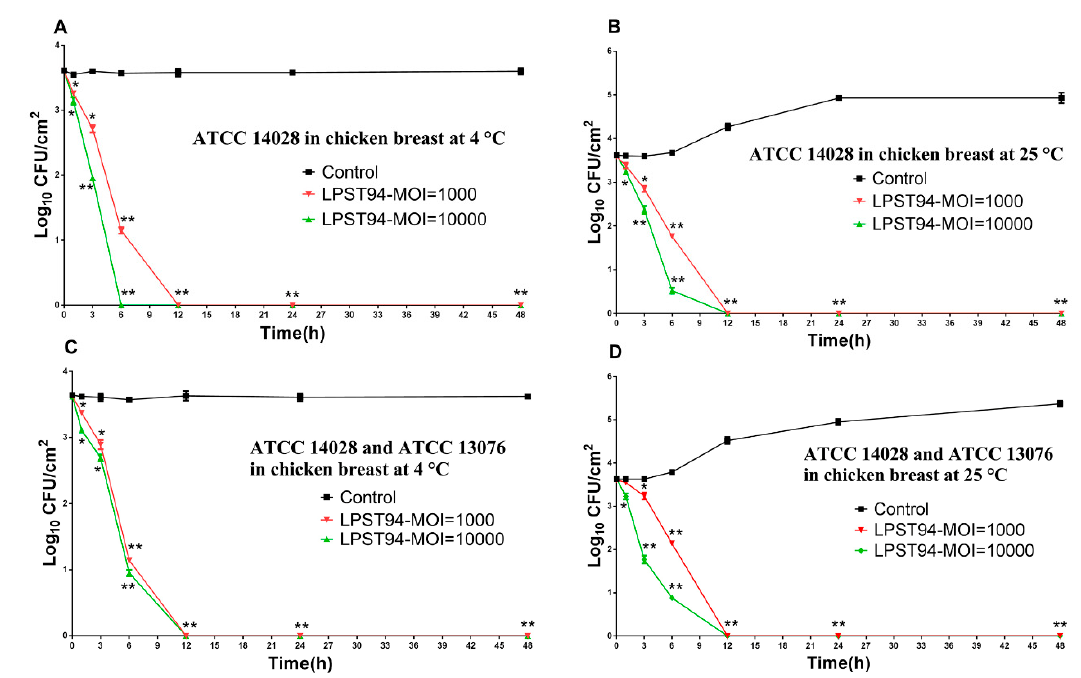
Figure 6. E ff ectiveness of phage LPST94 in reducing the S. Typhimurium ATCC 14028 and S. Enteritidis ATCC 13076 in chicken breast. ( A ) E ff ect of phage LPST94 on growth of S. Typhimurium ATCC 14028 on chicken breast at 4 ◦ C, ( B ) E ff ect of phage LPST94 on growth of S. Typhimurium ATCC 14028 on chicken breast at 25 ◦ C, ( C ) E ff ect of phage LPST94 on growth of Salmonella mixture ( S. Typhimurium ATCC 14028 and S. Enteritidis ATCC 13076) on chicken breast at 4 ◦ C, and ( D ) E ff ect of phage LPST94 on growth of Salmonella mixture ( S. Typhimurium ATCC 14028 and S. Enteritidis ATCC 13076) on chicken breast at 25 ◦ C. Values represent mean with standard deviation of three determinations. ** Significance of p < 0.01; * Significance of p < 0.05.